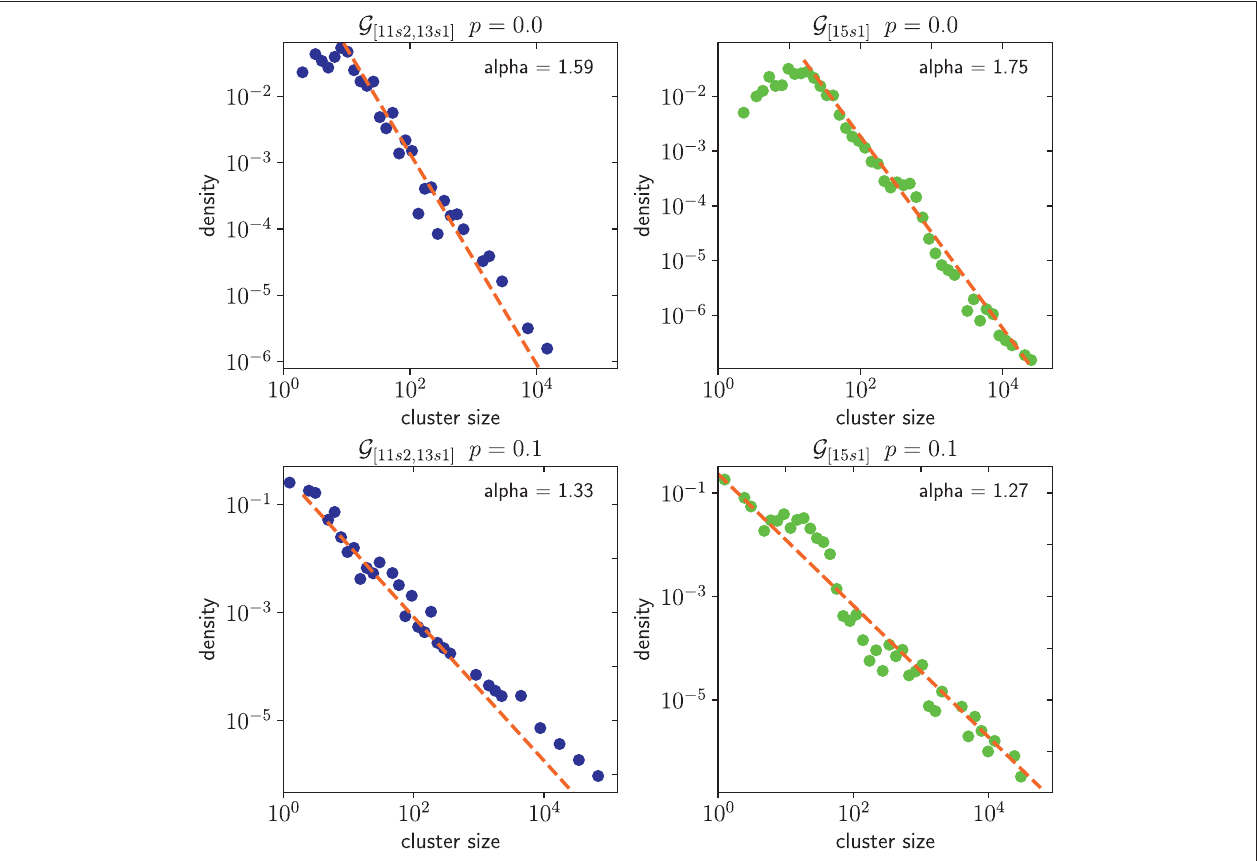
FIGURE 6 | Cluster size distribution of G [ 11 s 2 , 13 s 1 ] and G [ 15 s 1 ] for p (cid:2) 0.0 p (cid:2) 0 . 0 and p (cid:2) 0.1 p (cid:2) 0 . 1. The alpha values of the power-law distribution fi ts are also